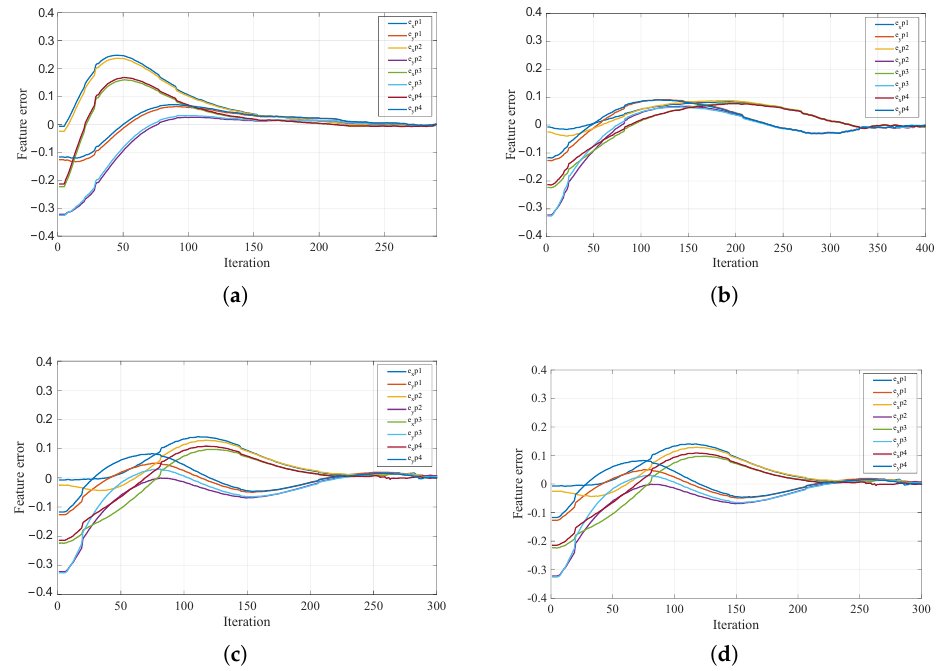
Figure 6. The real world result of the feature errors in different methods for the same scenario. ( a ) Feature errors in PBVS approach. ( b ) Feature errors in IBVS approach. ( c ) Feature errors in HVS approach. ( d ) Feature errors in DHVS